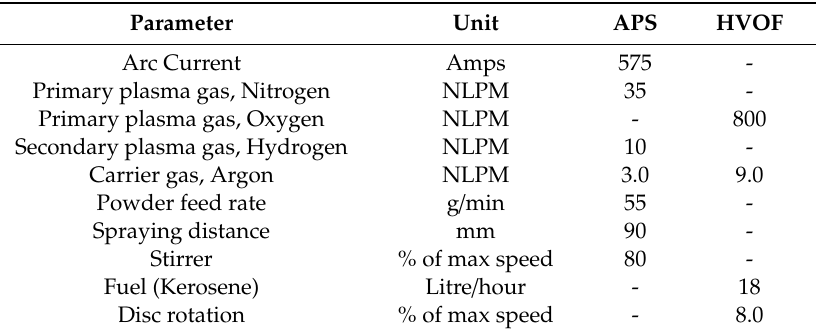
Table 1. Preparation parameters for APS and HVOF